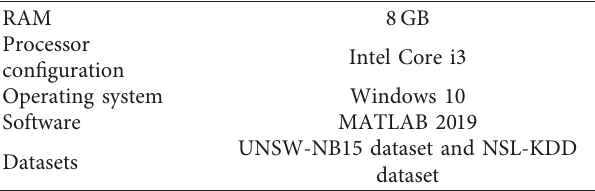
Table 3: The hardware and software used in the experiments. RAM 8